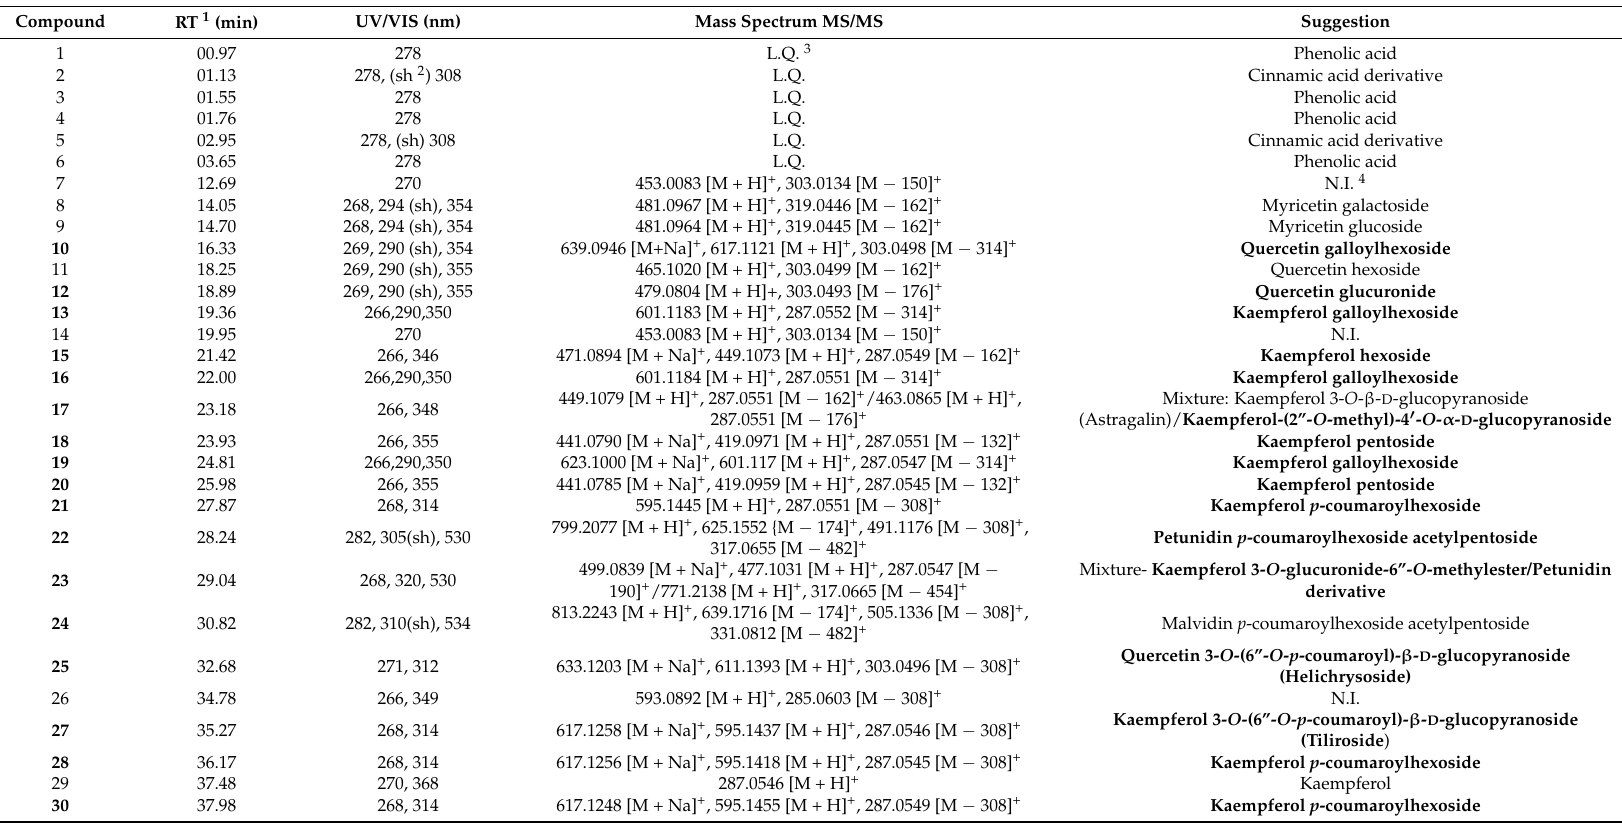
Table 2. Chromatographic and spectrometric data (UPLC-PAD-ESI-QTOF-MS) of phenolic constituents from T. pulchra petal extracts (acidified